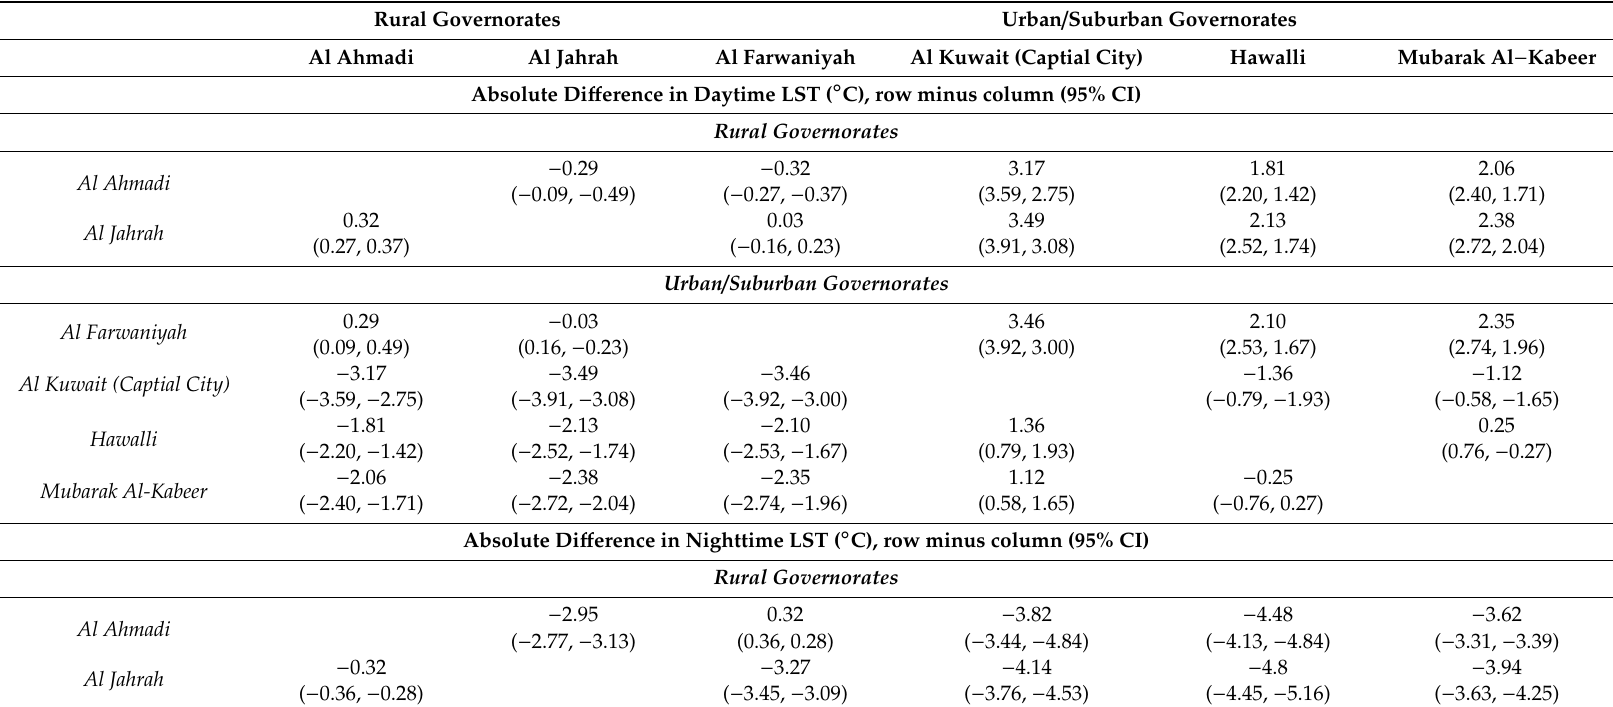
Table 2. Matrix of di ff erences in land surface temperature between governorates in Kuwait